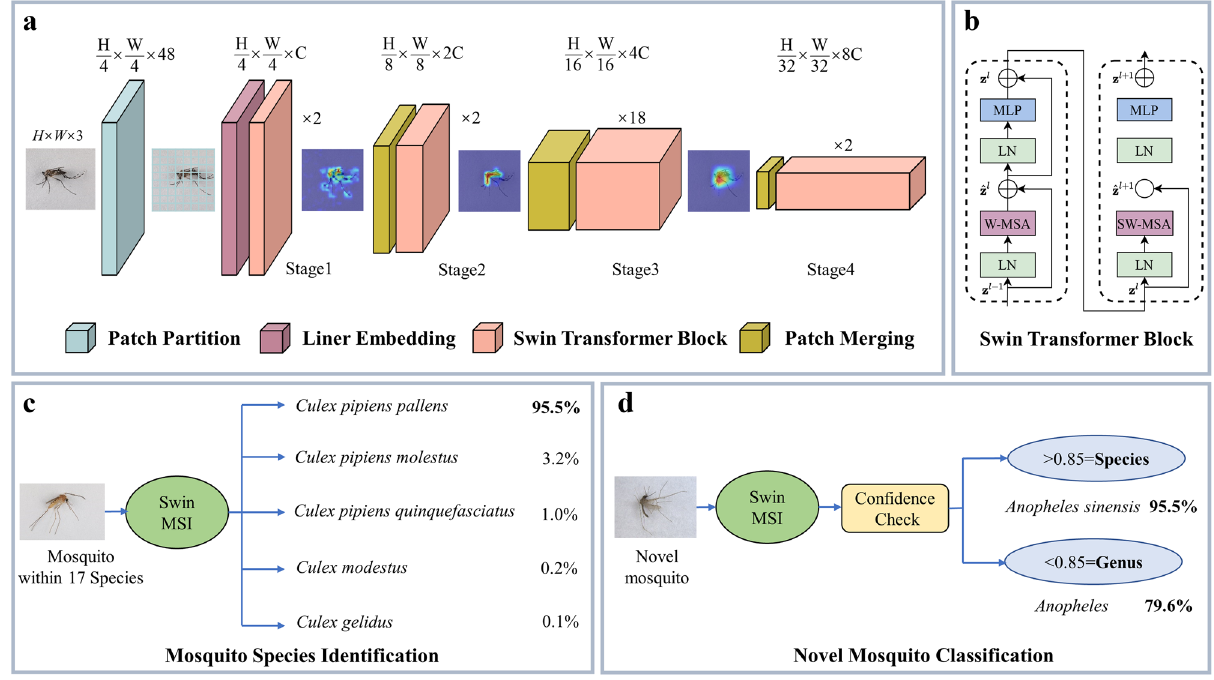
Figure 1. The Framework of Swin MSI. ( a )The basic architecture for mosquito features extraction and identification. Attention visualization generated by filters at each layer are shown. ( b ) Details for Swin Transformer block. ( c ) For mosquito within our dataset 17 species, output is the top 5 confidence species. ( d ) For mosquito beyond 17 species (defined as novel species), whether the output is a species or a genus is decided after comparing with confidence